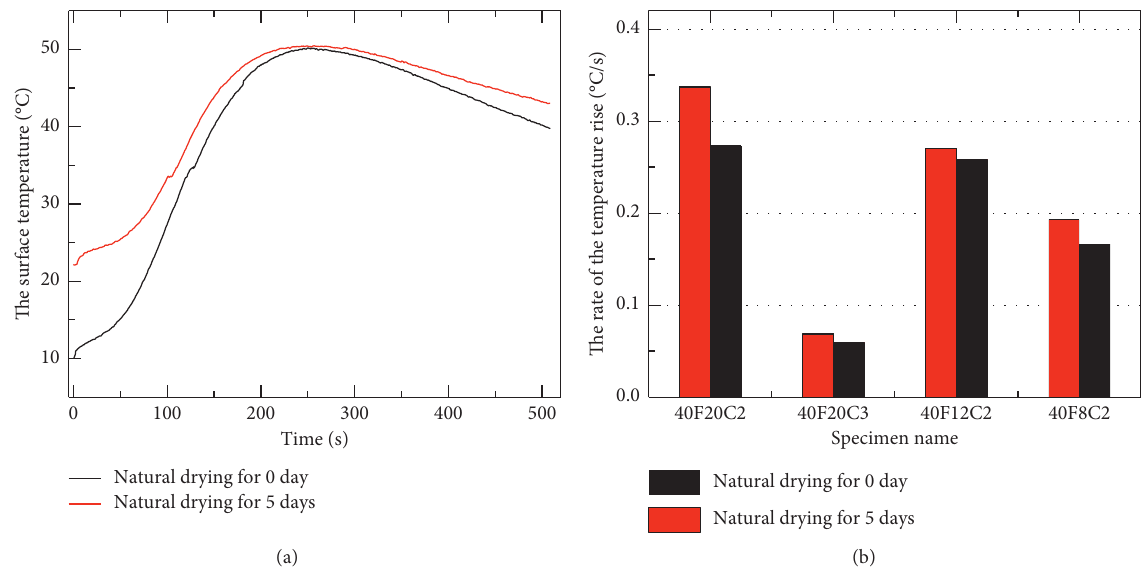
Figure 7: (a) The surface temperature depended on time for specimen 40F20C2 with different water contents in the concrete cover. (b) The rate of the temperature rise in concrete surfaces with different concrete humidity for different